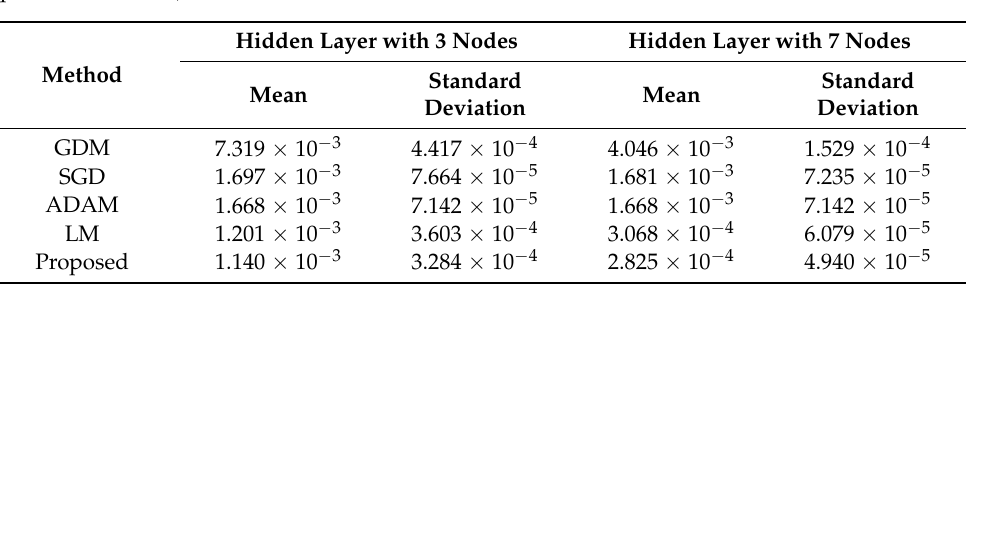
Figure 4. Error convergences of the proposed training method and the previous methods (GDM: gradient descent with momentum, SDG: stochastic gradient descent, ADAM: adaptive moment estimation, and LM: Levenberg–Marquardt) up to 200 iterations: ( a ) with 3 hidden nodes and ( b ) 7 hidden nodes. Table 1. Training performance for the pH process after 100,000 iterations—training errors (mean squared error; MSE).